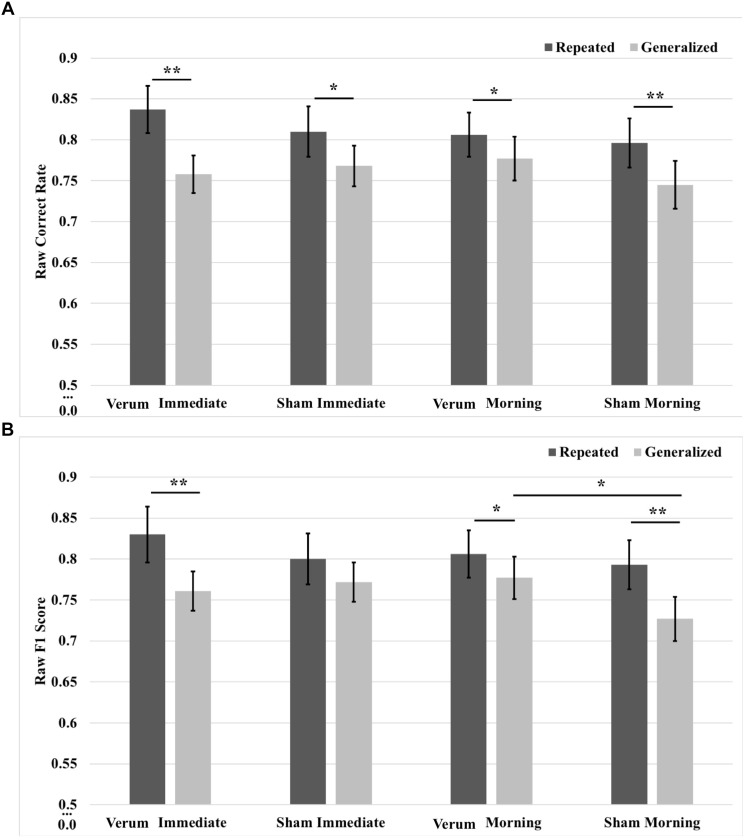
Raw performance scores from immediate (pre-sleep) and morning (post-sleep) tests broken down for repeated and generalized images in the verum and sham stimulation conditions. (A) Raw correct scores. Performance on repeated images was significantly higher than on generalized images for verum and sham stimulation at both the immediate and morning tests. (B) Raw F1 scores. There was a simple effect of image type for verum stimulation at the immediate test, with performance on repeated images better on generalized images. There was a trend for sham stimulation performing better than verum stimulation at the immediate test on generalized images; however, performance for sham stimulation on generalized images declined over sleep. Following sleep, the significant effect of image type remained for verum stimulation and was additionally seen for sham stimulation. There was a simple effect of stimulation condition at the morning test for generalized images, where verum stimulation led to improved performance compared to sham stimulation. Note that no significant effect was observed at the immediate test for tDCS applied during training for either image type. ∗p < 0.05, ∗∗p < 0.01, error bars represent ±1 SEM. Some of the immediate test data in (B) is also presented in Ketz et al. (2018).